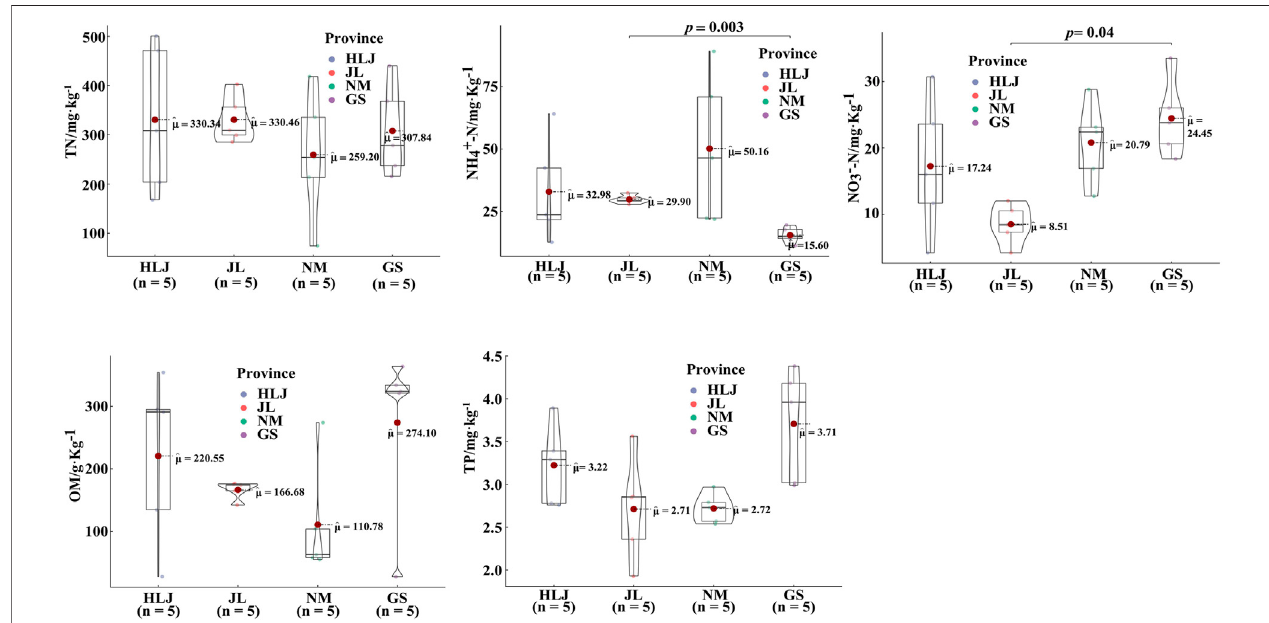
FIGURE 2| The physiochemical indicators ofcomposting toilet samples. The fi gure shows box plots, dot plots and violin plots of TN, TP, NH 4+ -N, NO 3 -N and OM in different provinces, in which û represents the mean of 5 samples and n represents the number of samples. HLJ, JL, NM and GS represent Heilongjiang Province, Jilin